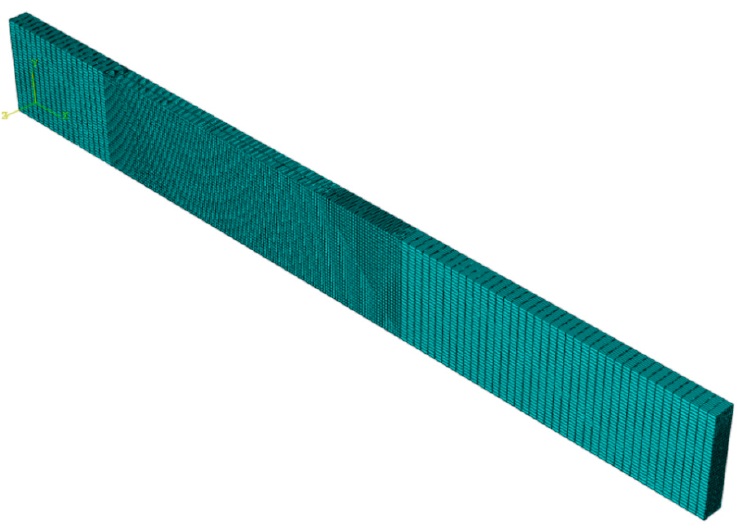
Figure 4. Numerical model of the DCB beam.